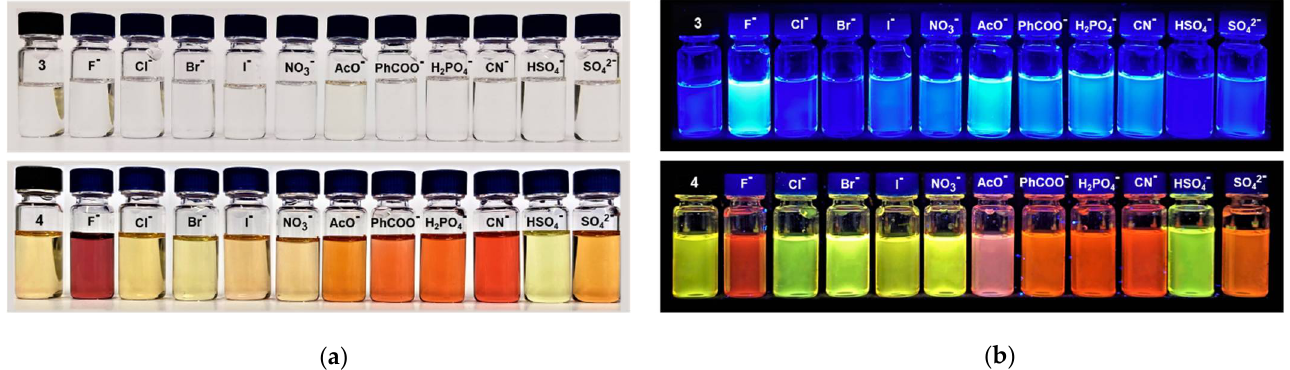
Figure 8. Color changes of 10 − 4 M solutions of 3 and 4 in the presence of 10 equiv. of various anions (added as TBA salts) in DMSO + 0.5% H 2 O: ( a ) under ambient light and ( b ) under a UV lamp (365 nm).